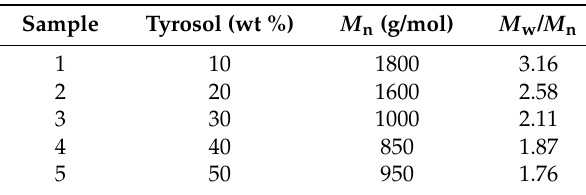
Table 1. Results of the transesterification reaction of P(3-HB- co -4HB) by tyrosol in the presence of